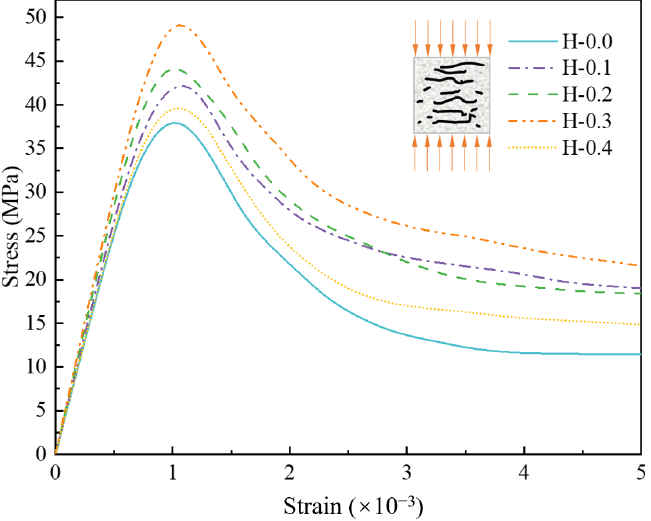
Figure 25. Numerical simulation of compressive stress-strain curve of hybrid fiber-reinforced LHPCC.